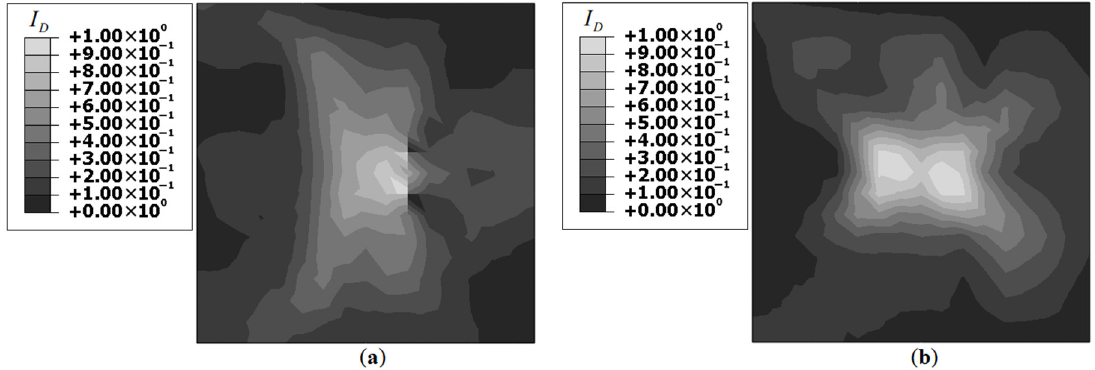
Figure 12. iFEM reconstructed 𝐼 (cid:3005) distribution for Damage Case-1 using: ( a ) Unitcell-1, and ( b ) Unitcell-2.